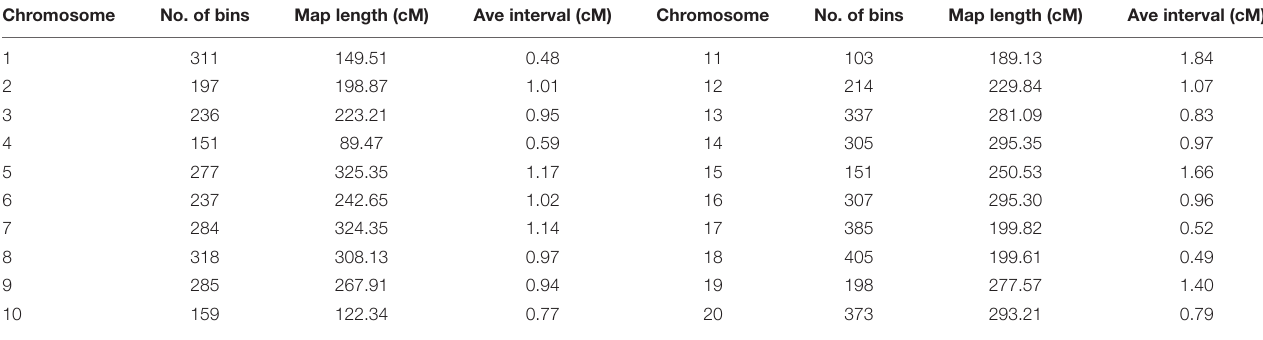
TABLE 3 | Distribution of polymorphic bins for each chromosome of the 392 RILs mapping population of the cross Zheng 9525 × Handou 10.